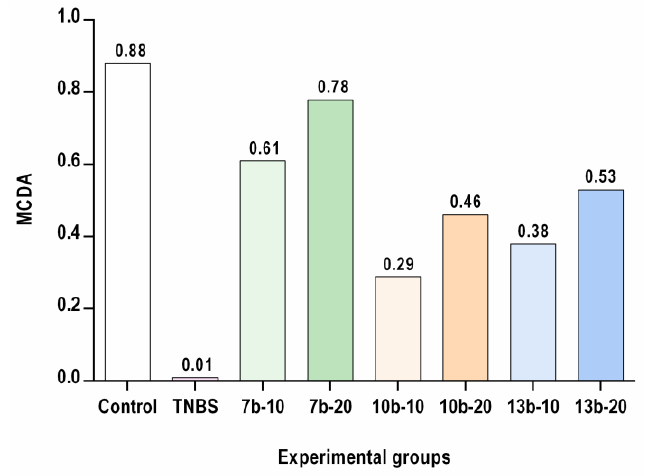
Figure 9. Multi-criteria decision analysis (MCDA) comparing the effect of the application of the studied compounds on the decrease/increase in the measured parameters compared to the control (group of rats without the studied compounds and without induction of colitis with TNBS solution).